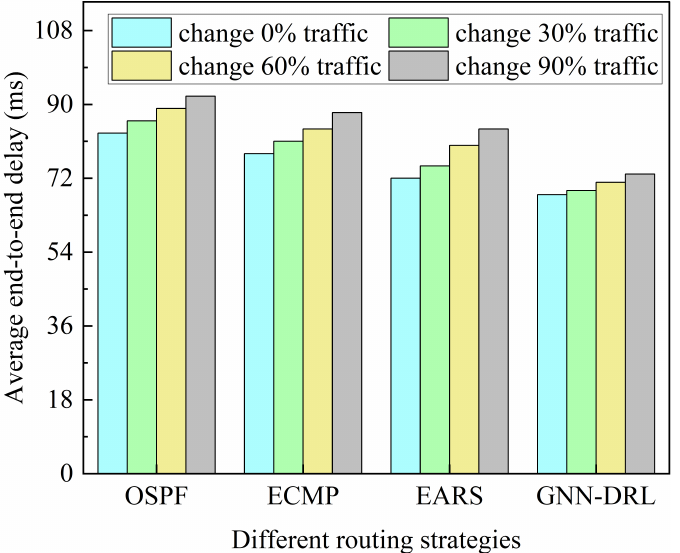
Figure 12. Optimized performance of average end-to-end delay under different traffic